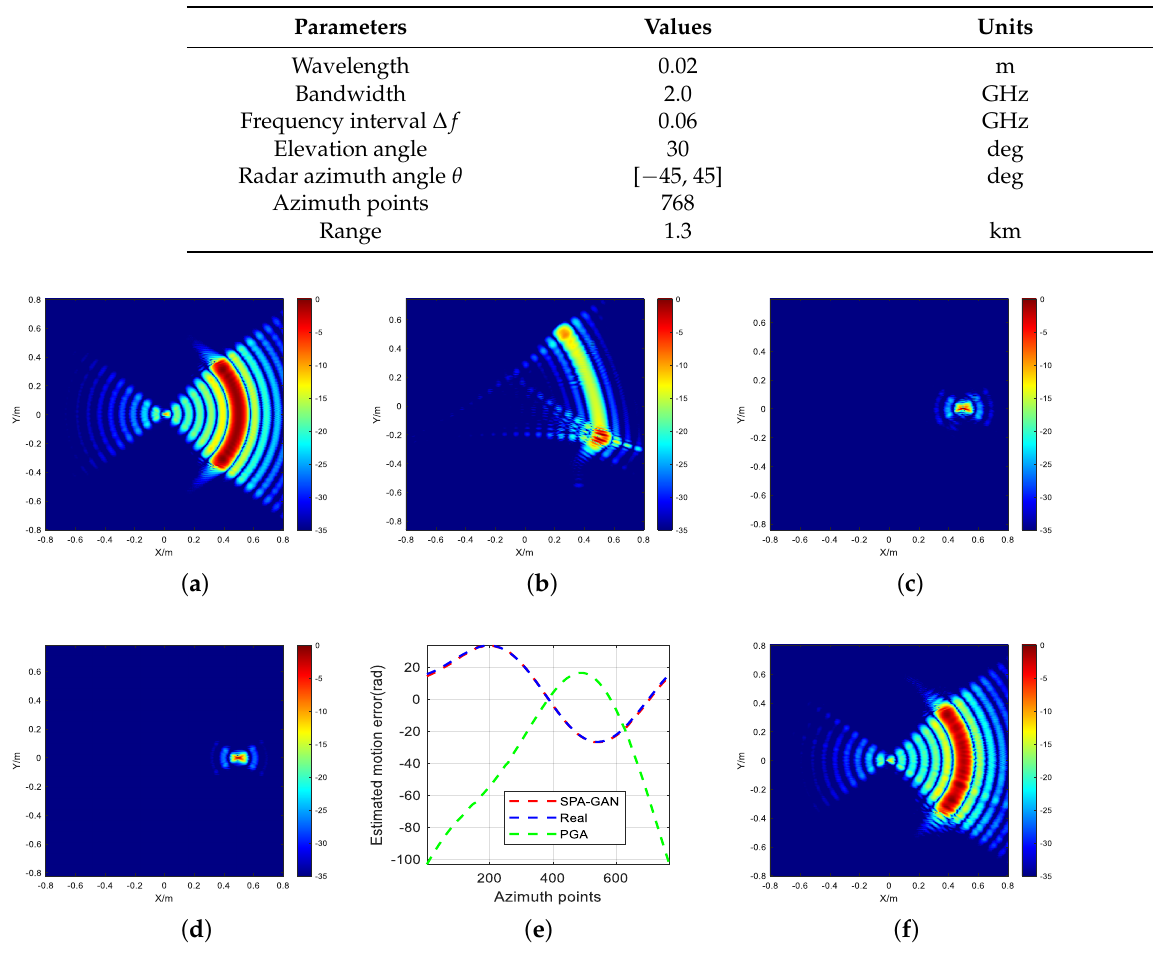
Figure 8. Simulation experiment results of an arc target: ( a ) the BP result with the ideal trajectory; ( b ) the BP result with the real trajectory; ( c ) the PGA result; ( d ) the MSE result; ( e ) the estimated motion error of the proposed SPA-GAN, PGA and real motion error; ( f ) the proposed SPA-GAN